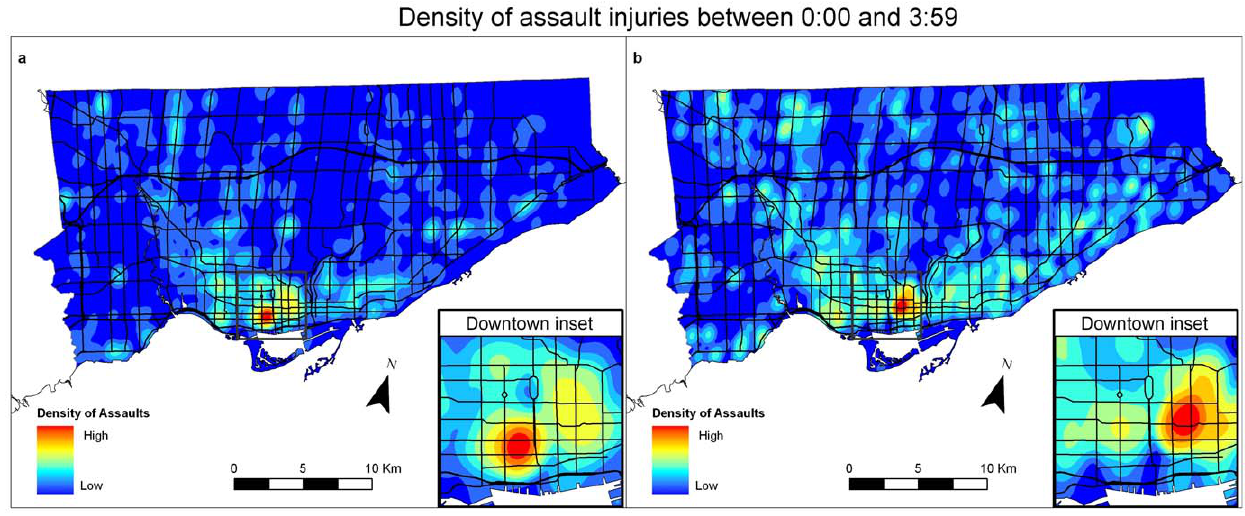
Figure 4. Assault injury densities in Toronto using data aggregated for 4 hours (00:00 and 03:59 hrs). Figure 4a: Density of assault injuries between 00:00 and 03:59 for EMS dataset. Figure 4b: Density of assault injuries between 00:00 and 03:59 for NACRS dataset.